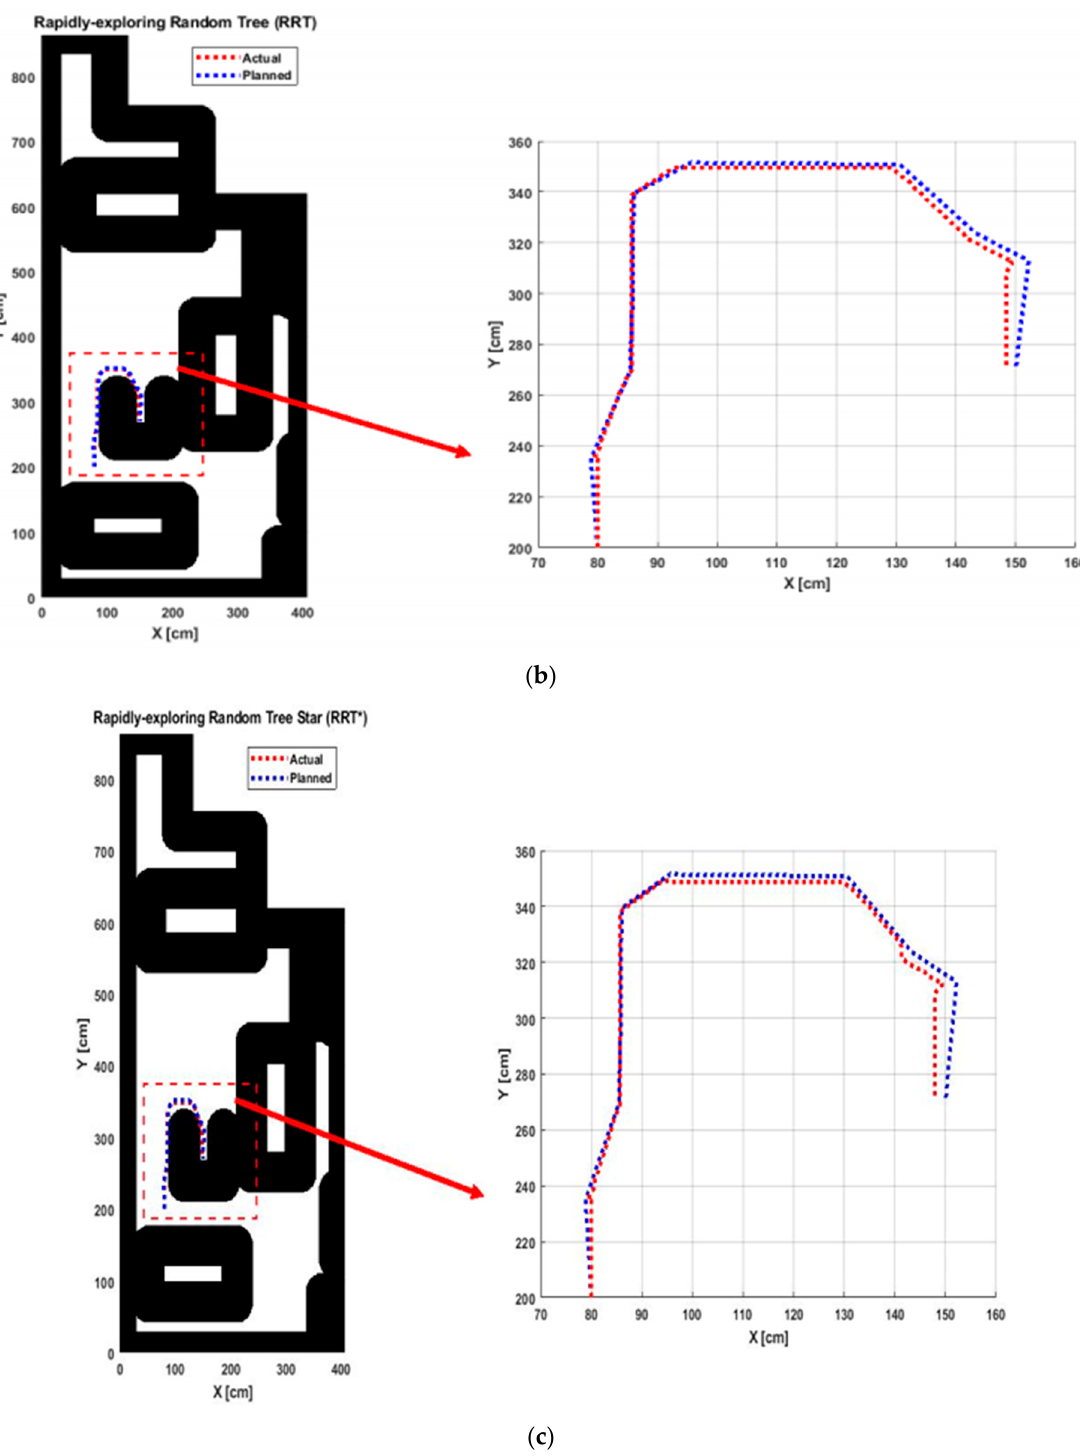
Figure 14. The experimental paths that are generated by using different path planning techniques in Map2. The blue line is the planned path, while the red line is the actual path. ( a ) The path planned by using the PRM technique. ( b ) The path planned by using the RRT technique. ( c ) The path planned by using the RRT* technique.